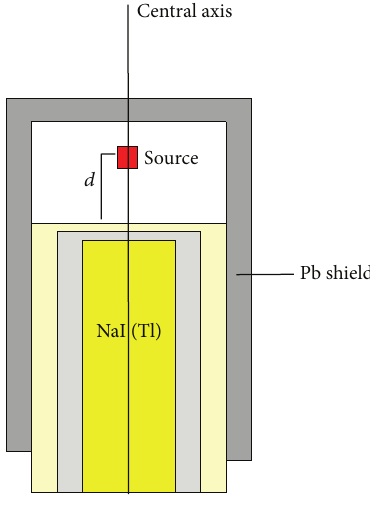
Figure 2: Considered source and detector location in